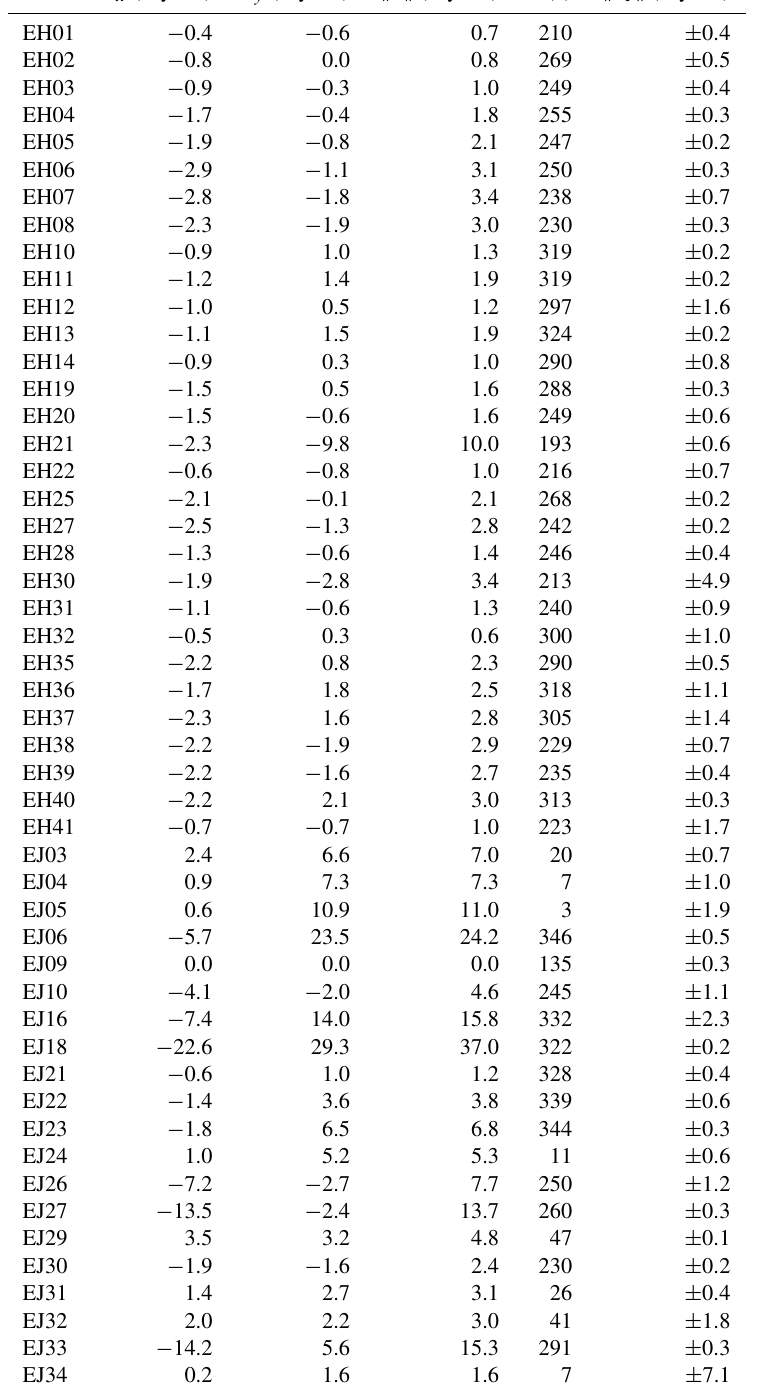
Table 1. Horizontal velocities for Hurd and Johnsons glacier stakes on 13 February 2013, calculated using the first-degree polynomial for velocity derived from the second-degree polynomial adjustment for stake positions. From left to right: stake name, X and Y components of horizontal velocity ( v x , v y ), absolute value of horizontal velocity ( (cid:107) v (cid:107) ), azimuth of horizontal velocity vector ( θ ), and error estimate for the horizontal velocity ( (cid:107) e v (cid:107) ), calculated using the polynomial